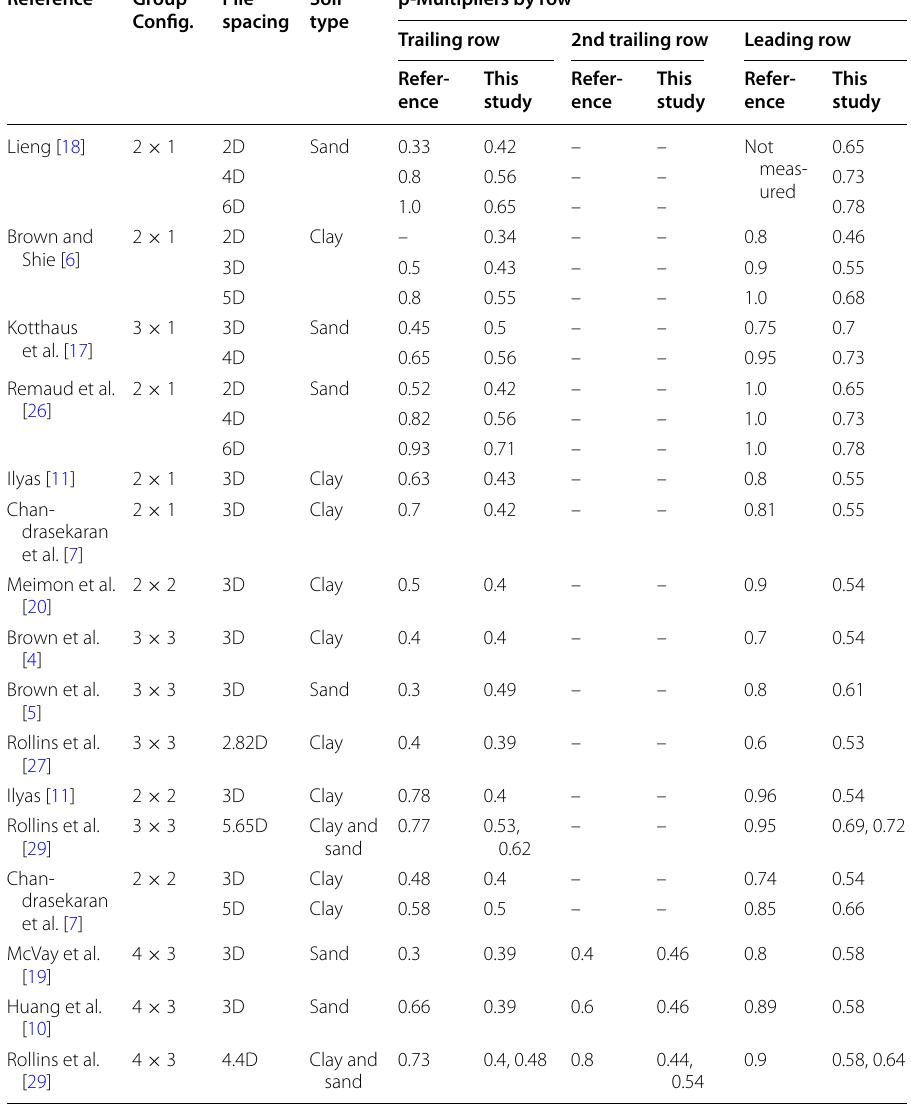
Table 3 Comparison of f obtained from the present study with publishing cases m Reference Group